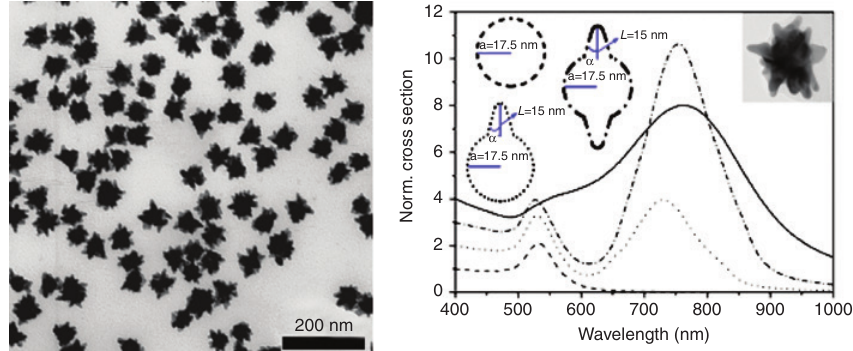
Figure 6: Left: TEM picture of nanostars. Right: Experimental (solid line) and BEM calculated absorption spectra for Au nanostars, aver- aged over the measured distribution of tip-aperture angles α (broken curves). The morphologies corresponding to the various calculations are graphically depicted along with a TEM image. Adapted from Ref. [66], Copyright IOP Publishing. Reproduced with permission. All rights